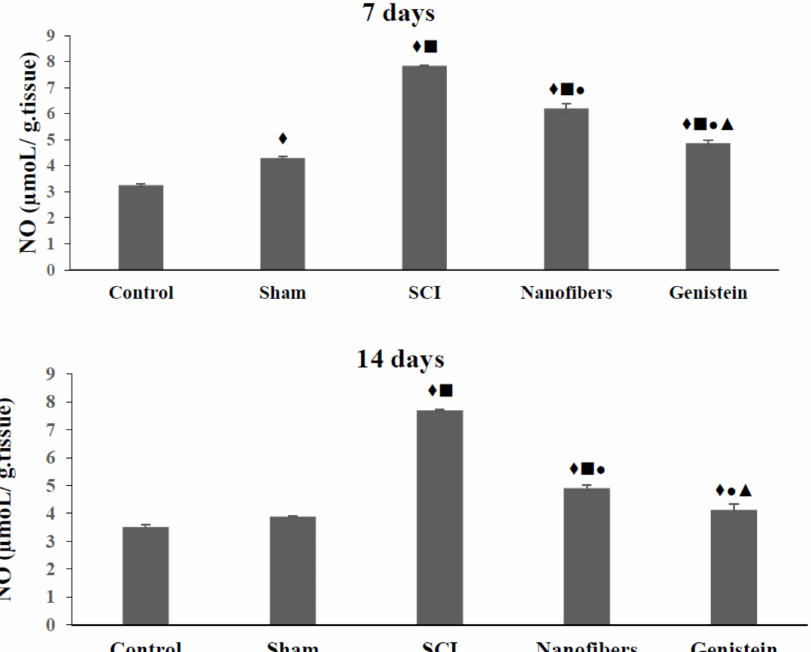
Figure 2. Mean concentration of Nitrous Oxide (NO) ( µ mol/g tissue) in spinal cord tissue. Nitrous oxide levels were significantly elevated in the injury group when compared with control ( (cid:7) ) and sham ( (cid:4) ) groups. Treatment with nanofibers and genistein nanofibers led to a significant ( ) decrease of NO levels when compared with spinal cord injury (SCI) group. Genistein nanofibers showed significant reduction in NO as compared to nanofibers ( (cid:78) ) group. Number of animals ( n = 5). (Mean ±